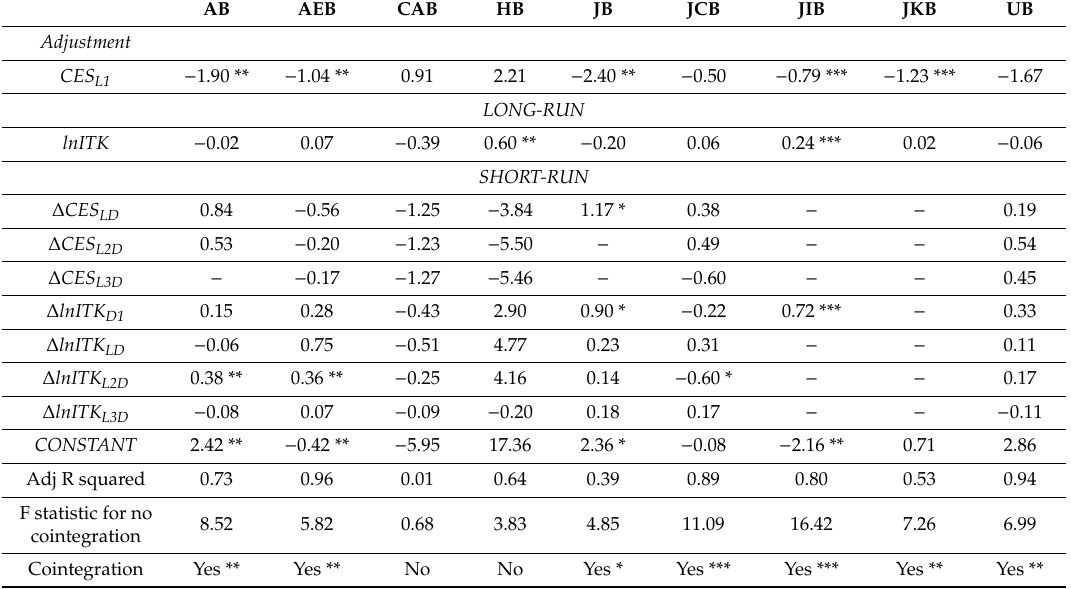
Table 6. Estimates of autoregressive distributed lag (ARDL) and error correction model (ECM) models for cost e ffi ciency scores (CES). AB AEB CAB HB JB JCB JIB